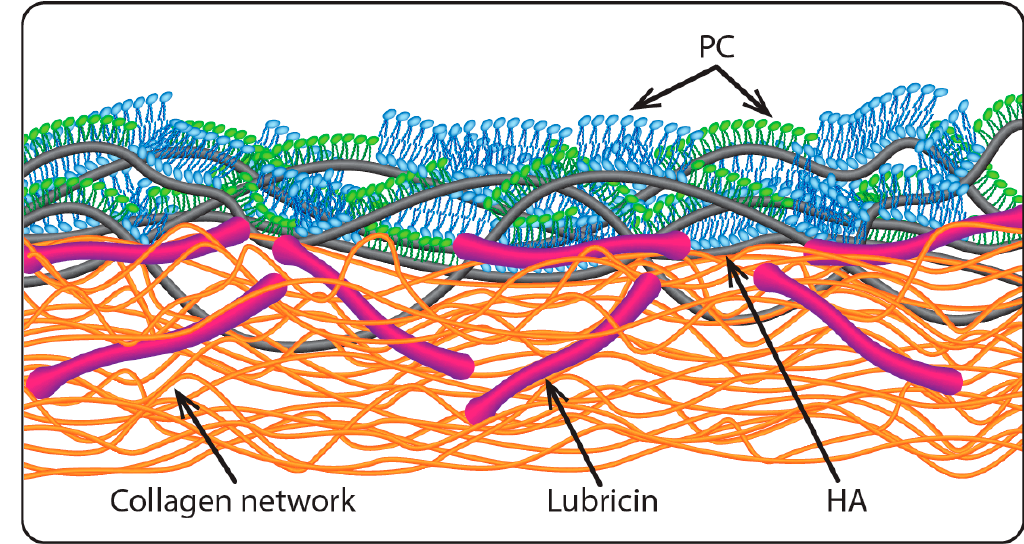
Figure 1. Illustrating the proposed boundary layer on articular cartilage [33], where lubricin molecules anchor hyaluronic acid (HA) chains at the articular cartilage surface and the HA is complexed with phosphatidylcholine (PC) layers exposing their highly hydrated phosphocholine groups at the very outer surface (the slip plane). Reproduced with permission from [33]. Copyright 2016, Annual